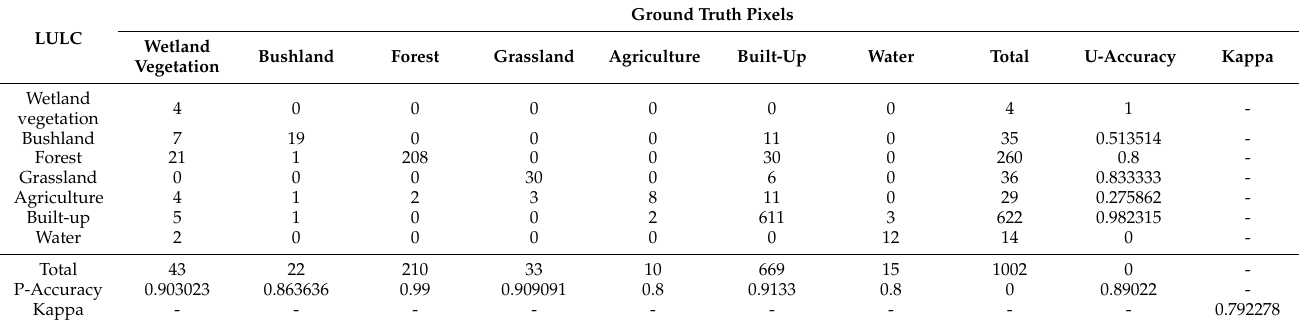
Table 2. Accuracy assessment results of LULC classification for image of